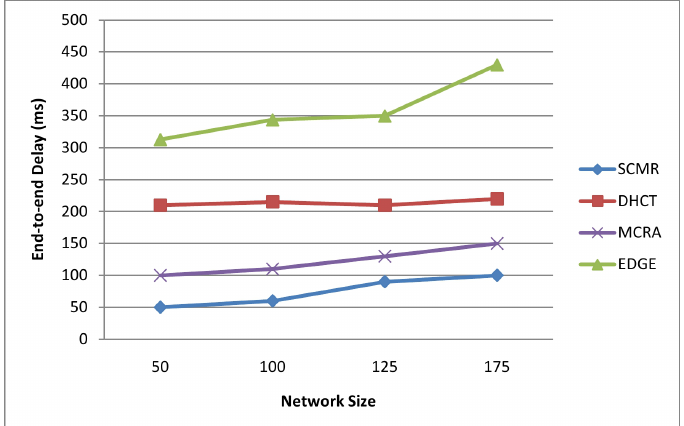
Figure 7. End-to-End Delay of Our Protocol Compared with Other